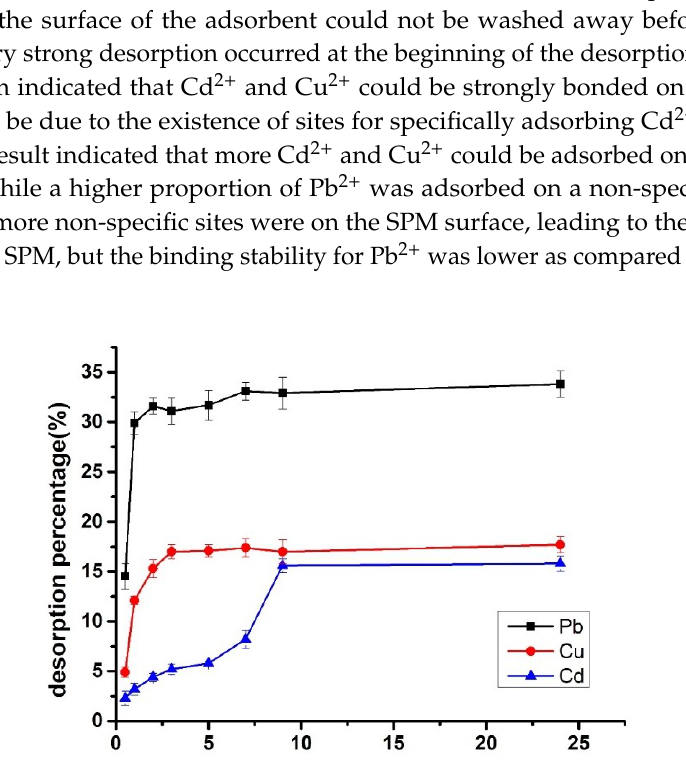
Table 4. Adsorption of metals on other silicate solid wastes.